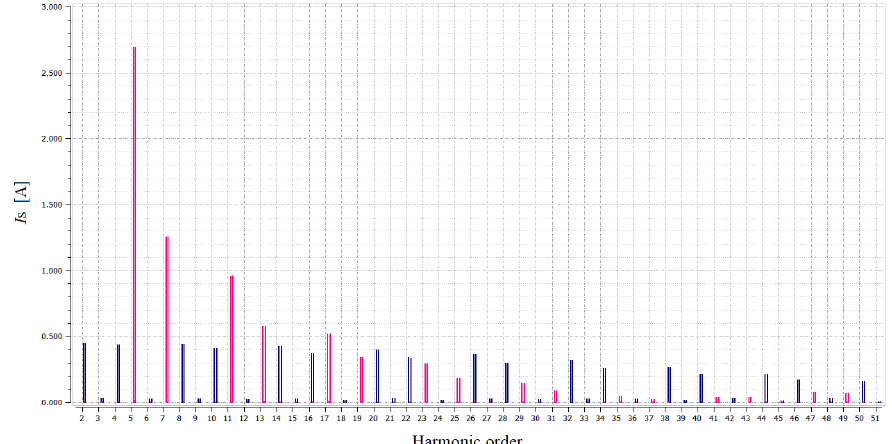
Figure 7. Example of the measured grid current spectrum for U DC = 250 V (the red manganese color represents the characteristic harmonics).